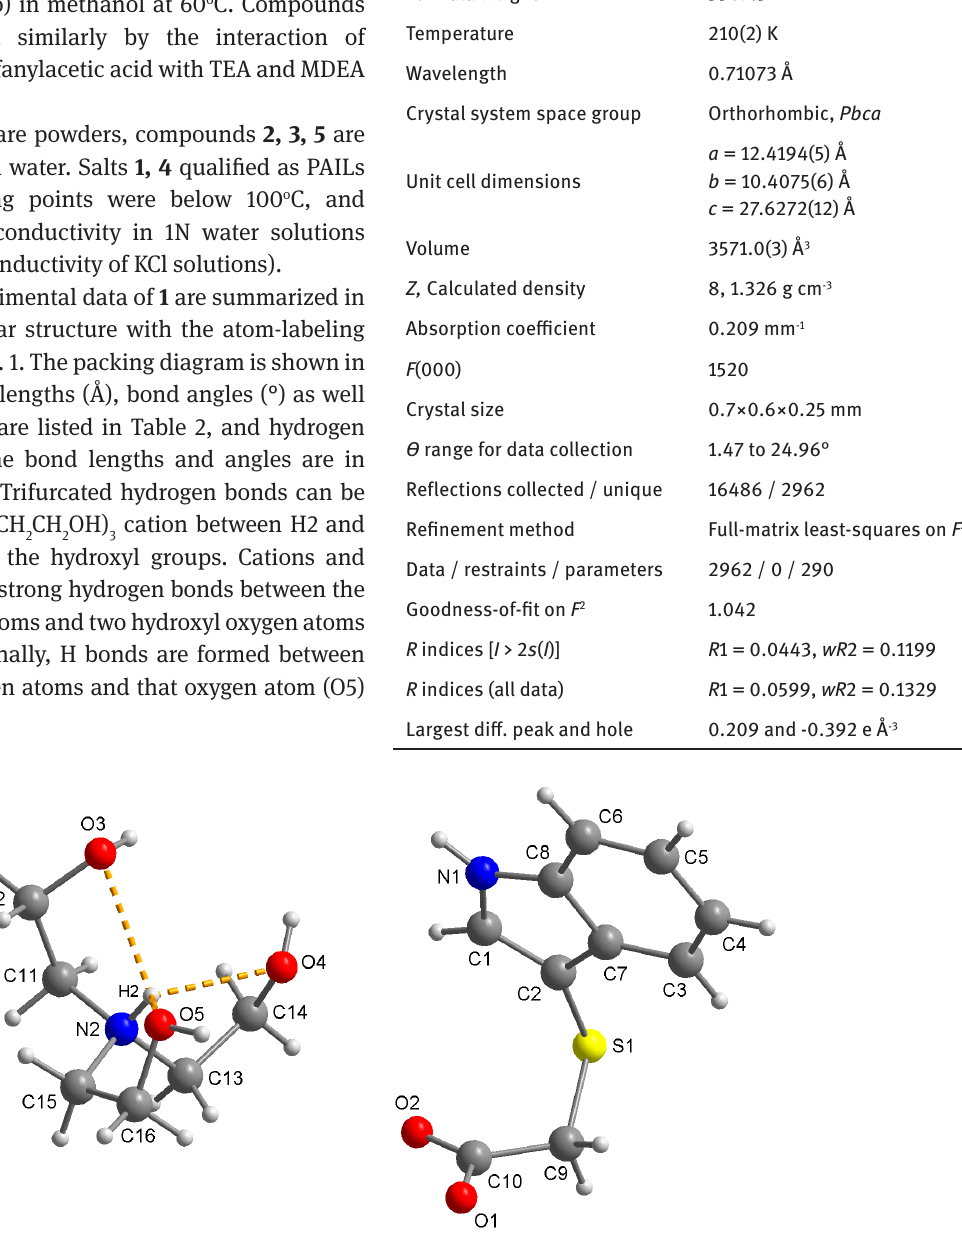
Figure 1: Molecular structure of 1 with the atom labeling scheme; hydrogen bonds as dotted